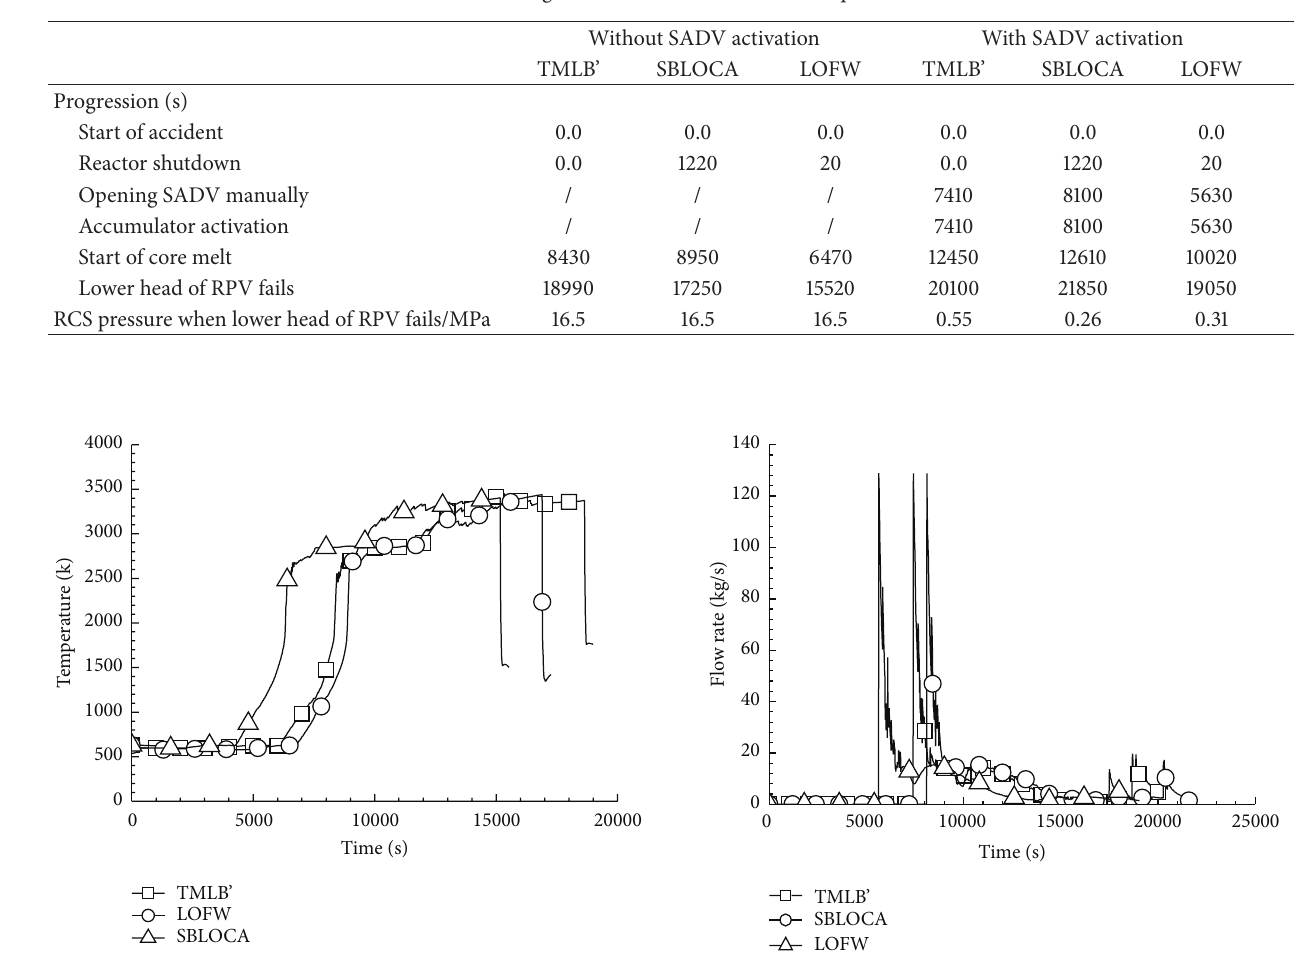
Table 1: Progressions of the three accident sequences.